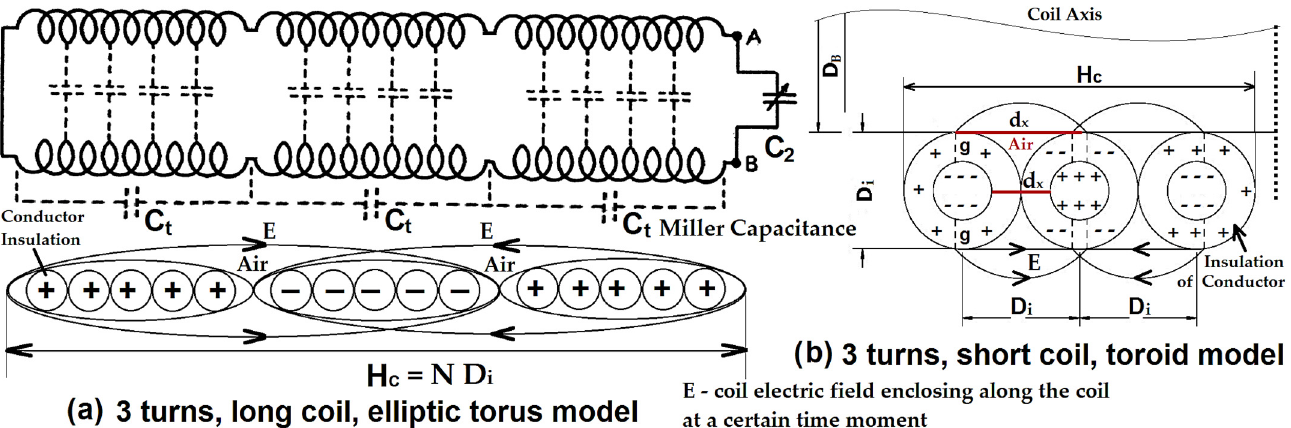
Figure 1. Coil antenna as a transmission line, with self-capacitance of the turns regarded in parallel; ( a ) long coil elliptic torus model with three long turns or three series C t capacitors; ( b ) short coil toroid model with three turns or three series capacitors.